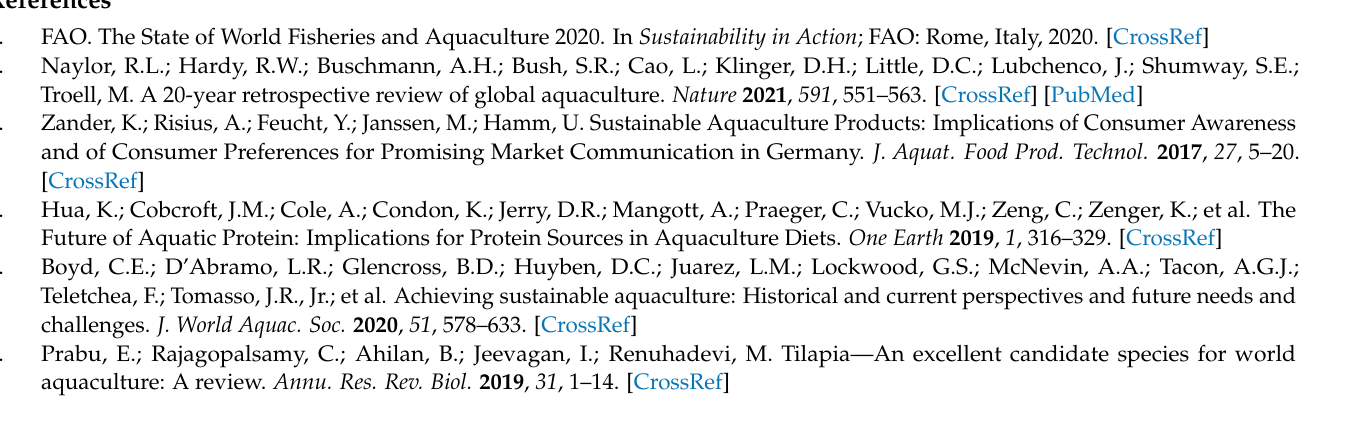
Table S1: Functional KEGG pathways for each fish and